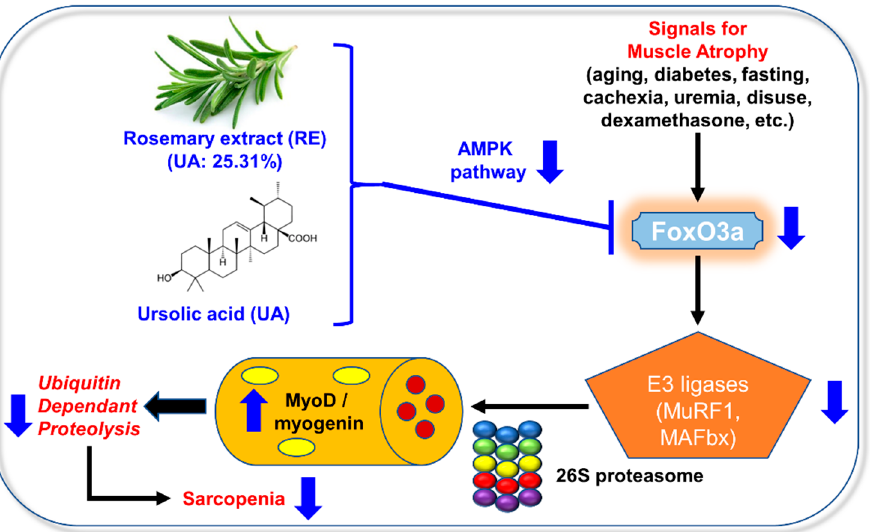
Figure 6. Proposed mechanism for the effects of rosemary extract (RE) on C2C12 cell differentiation and 5-aminoimidazole-4-carboxamide ribonucleoside (AICAR)-induced C2C12 myotube atrophy. ↑ : upregulate; ↓ :